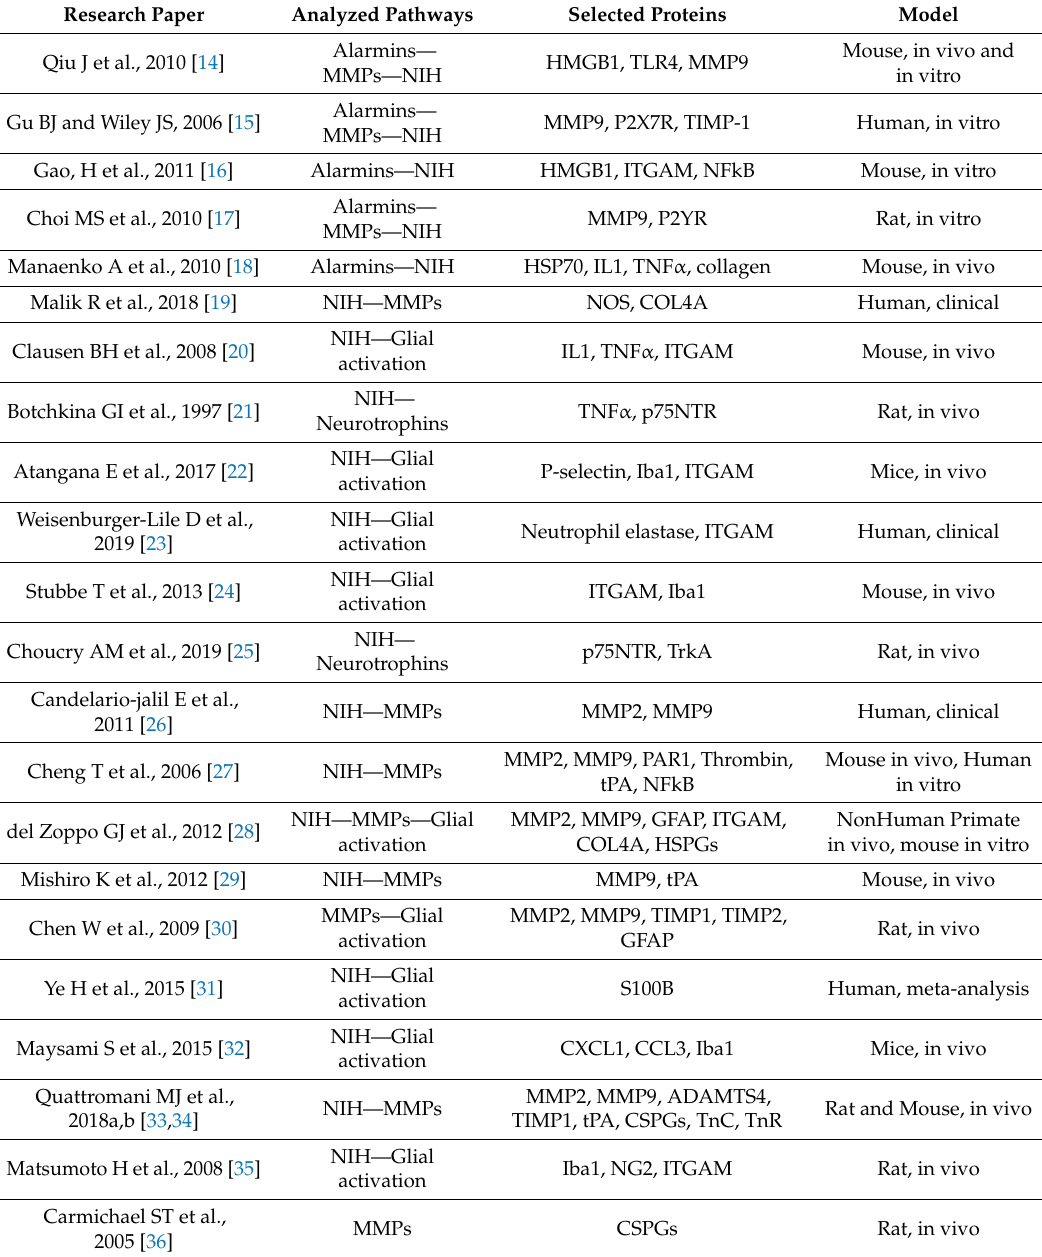
Table 1. Synoptic table of the main representative experimental studies analyzed to select 38 proteins used as input for the string database (Figures 1 and 2). NIH: neuro-immune hemostasis, MMPs: matrix metalloproteinases, ADAMTS: a disintegrin and metalloproteinase with thrombospondin motifs, TIMP: tissue inhibitor of metalloproteinases, CSPGs: chondroitin sulfate proteoglycan, HSPGs: heparan sulfate proteoglycan, TnC: tenascin-C, TnR: tenascin-R, tPA: tissue plasminogen activator, GFAP: glial fibrillary acidic protein, ITGAM: integrin subunit alpha M, HMGB1: high-mobility group box 1 protein, TLR: Toll-like receptor, NF κ B: nuclear factor- κ